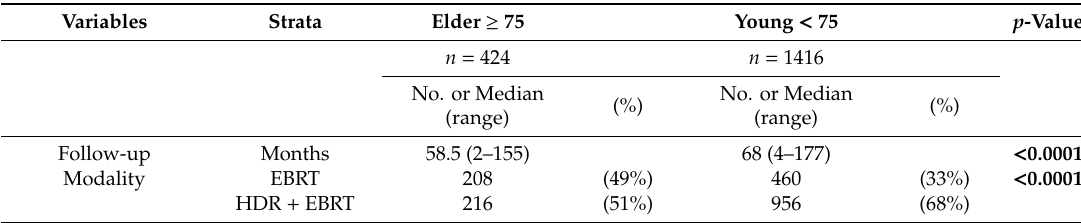
The 10-year OCMFS rates in patients aged ≥ 75 years were 94.6% (95% confidence interval [CI],